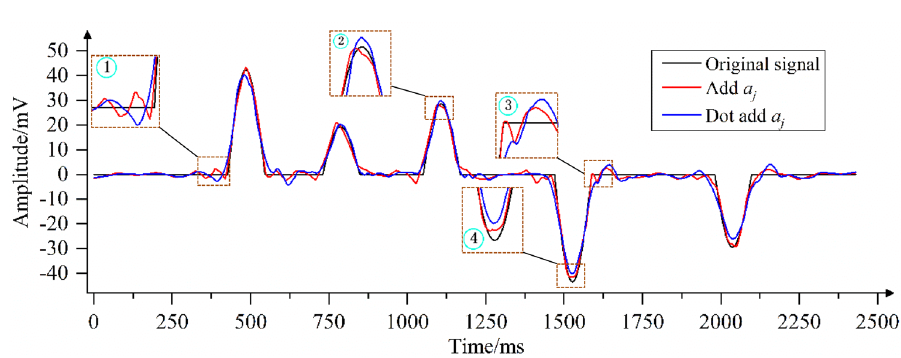
Figure 10. Comparison of the effect of removing analog signal noise with the model with and without the addition of the coefficient a j